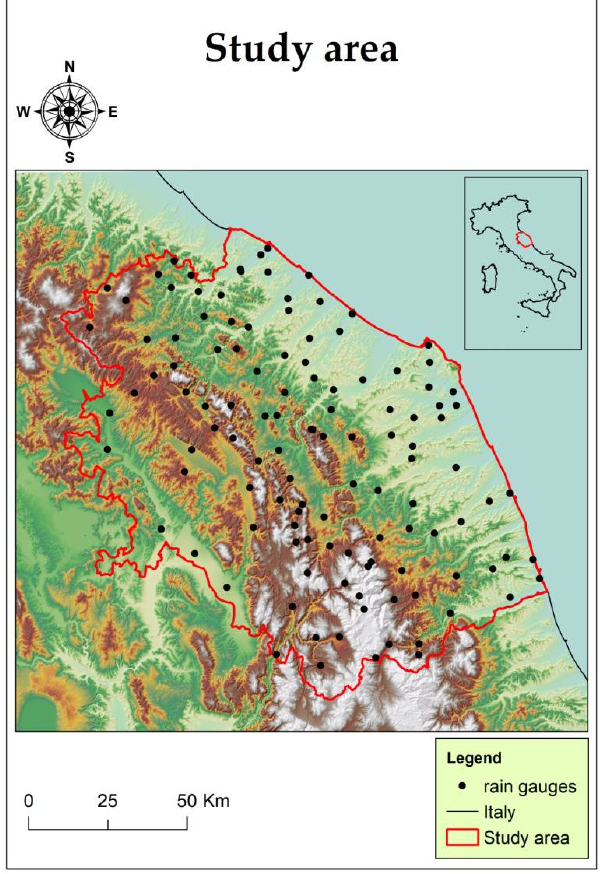
Figure 1. Map of the study area and positioning of rain gauges.